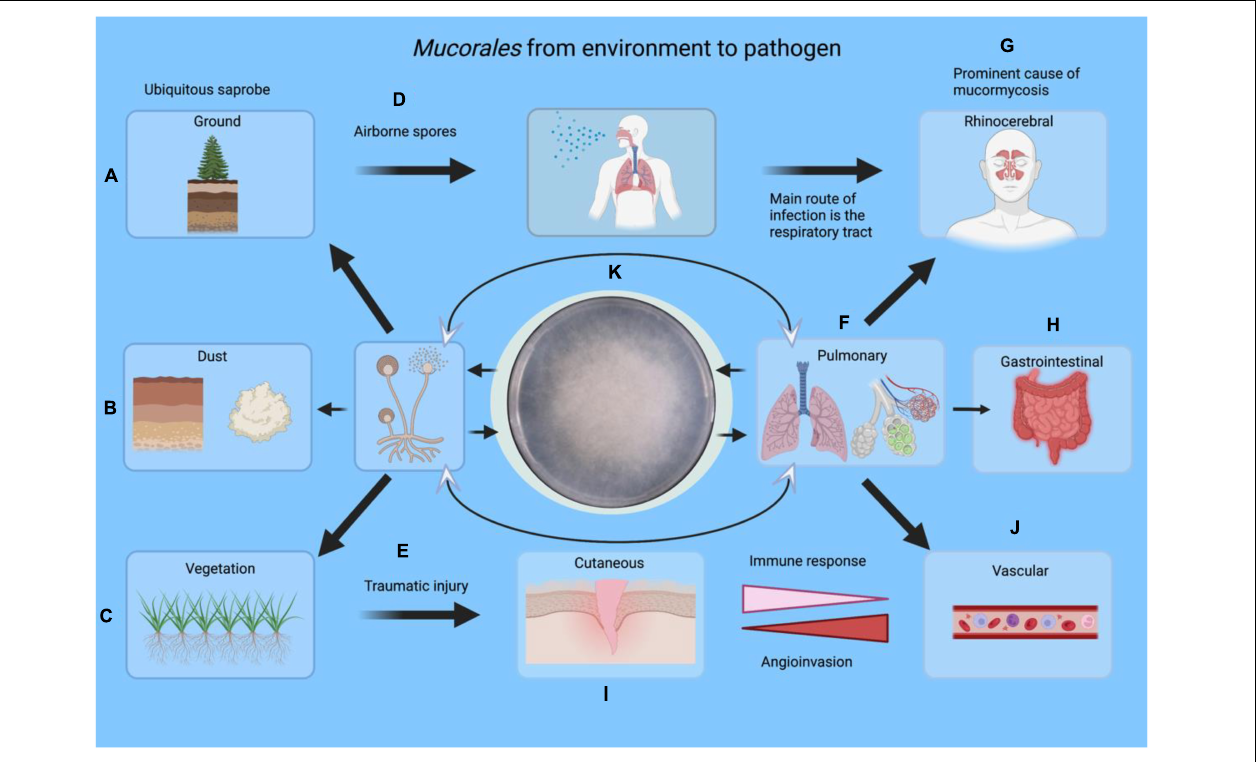
FIGURE 1 | An overview of infection routes of Mucorales from the environment toward the development as pathogens. Mucorales can be found in soil (A) , dust (B) , and vegetation (C) . The spores can infect humans through the respiratory tract via airborne spores (D) , injuries (E) , pulmonary (F) rhinocerebral (G) or the gastrointestinal tract (H) . Cutaneous cases, on the other hand, are associated with vegetal trauma or motor vehicle accidents (I) . Any of these local infections can cause vascular spread leading to thrombosis (J) . Specimens (F–I) can be obtained for laboratory diagnosis by culture (K) or other methods. Eventually, the fungus returns to the environment where it belongs. This figure was created in